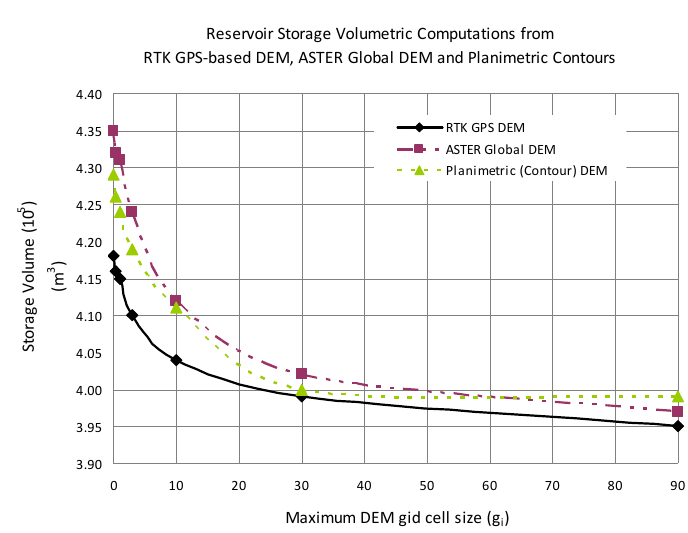
Figure 12. Results of volumetric computations from RTK GPS-DEM, ASTER-Global DEM and planimetric (contour) data sources in comparison with grid sizes.